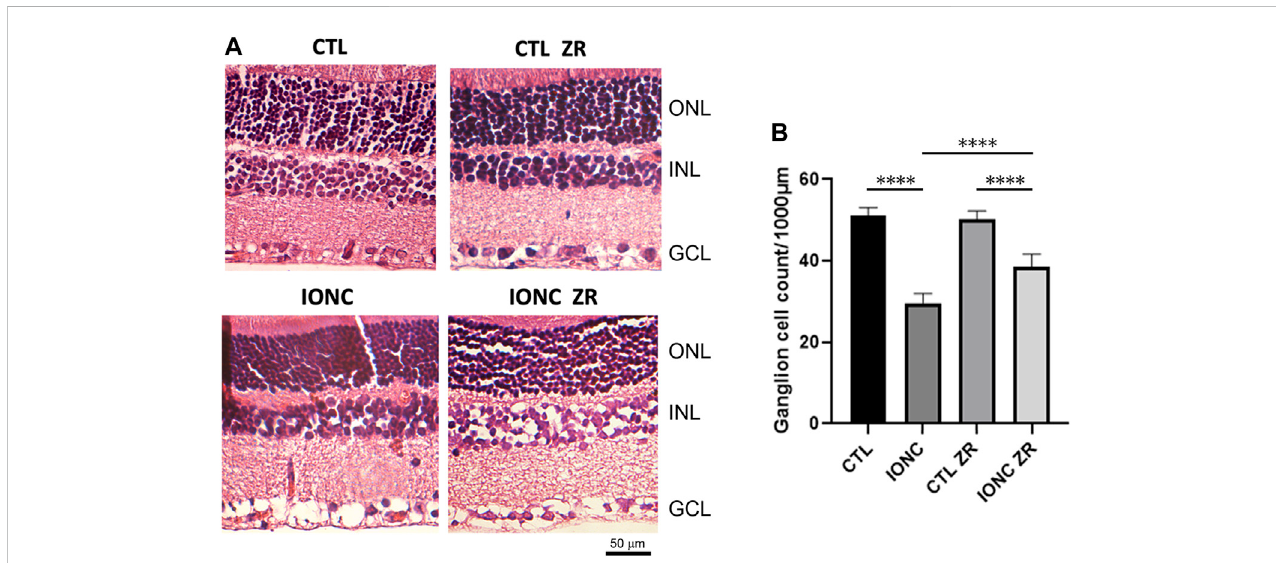
FIGURE 4 Anatomical structure of the retinas on the four experimental groups. Representative sections of the retina of treated animals stained with hematoxylin andeosin (A) .Thenuclearlayersoftheretinaareindicated:outernuclearlayer(ONL),innernuclearlayer(INL),andganglioncelllayer(GCL).Sizebar=50 µm. Quanti fi cation of the number of ganglion cells per 1,000 µm (B) . Bars represent the mean ± SD of all animals ( n = 21 fi elds per experimental group). Asterisks represent statistically signi fi cant differences (ANOVA). ****: p < 0.0001.